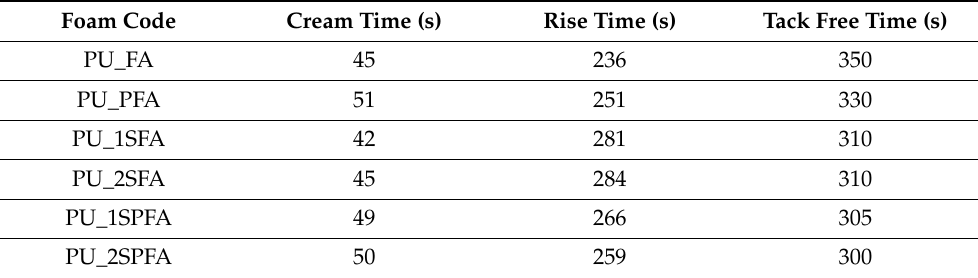
Table 2. Foaming parameters of polyurethane